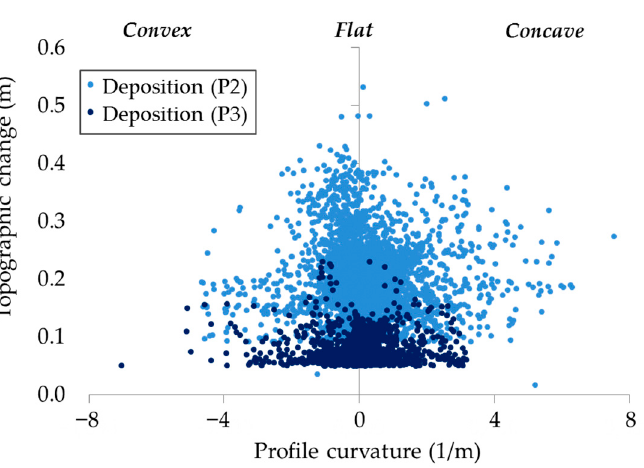
Figure 14. Profile curvature derived from 2017 digital elevation model (DEM) and compared to deposition behind check dams in P2 and in P3 by the DEMs of difference (DoD).